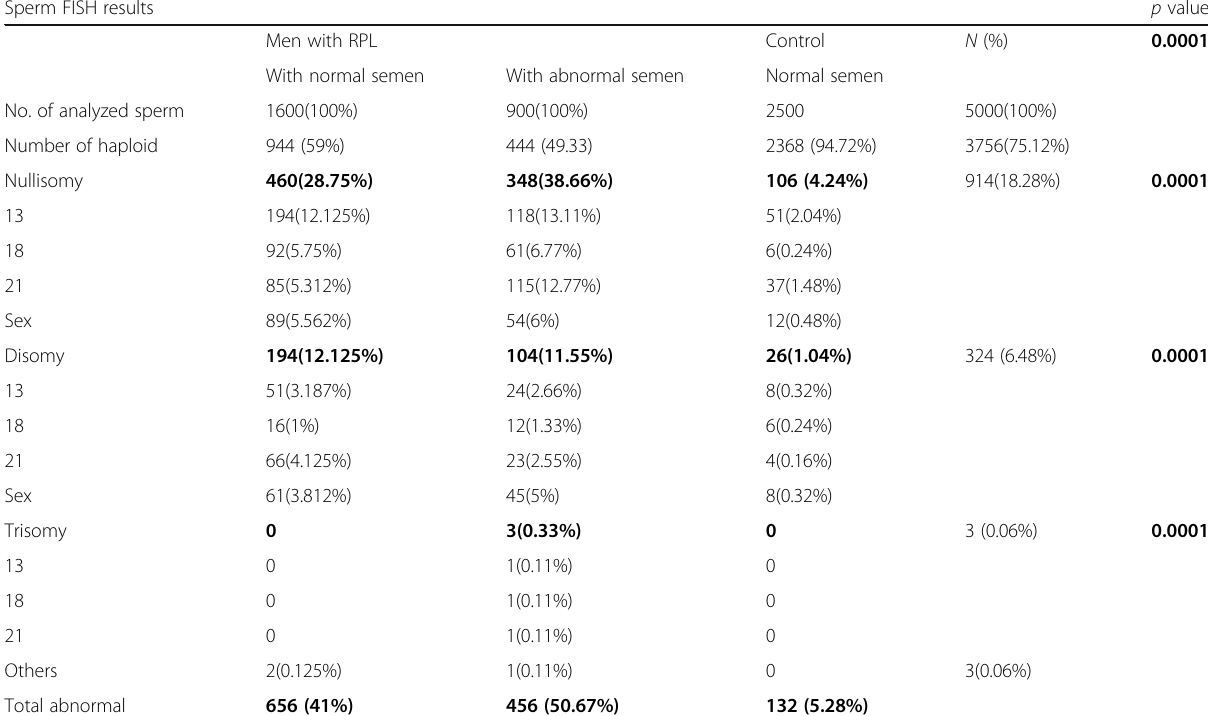
Table 2 Frequency of aneuploidy in men with RPL and normospermic men according to each chromosome and aneuploidy type Sperm FISH results p value